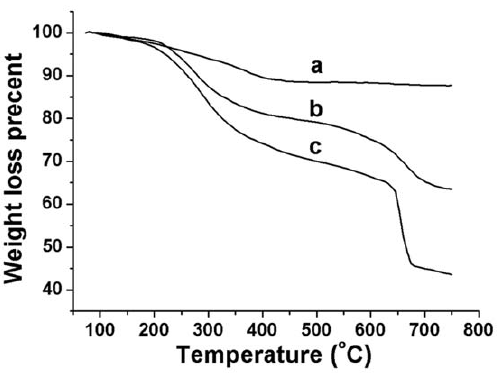
Figure 3. TGA curves. TGA curves of the IONPs (a), the CS-IONPs composites (b) and the adhesive CCS-IONPs composites(c).